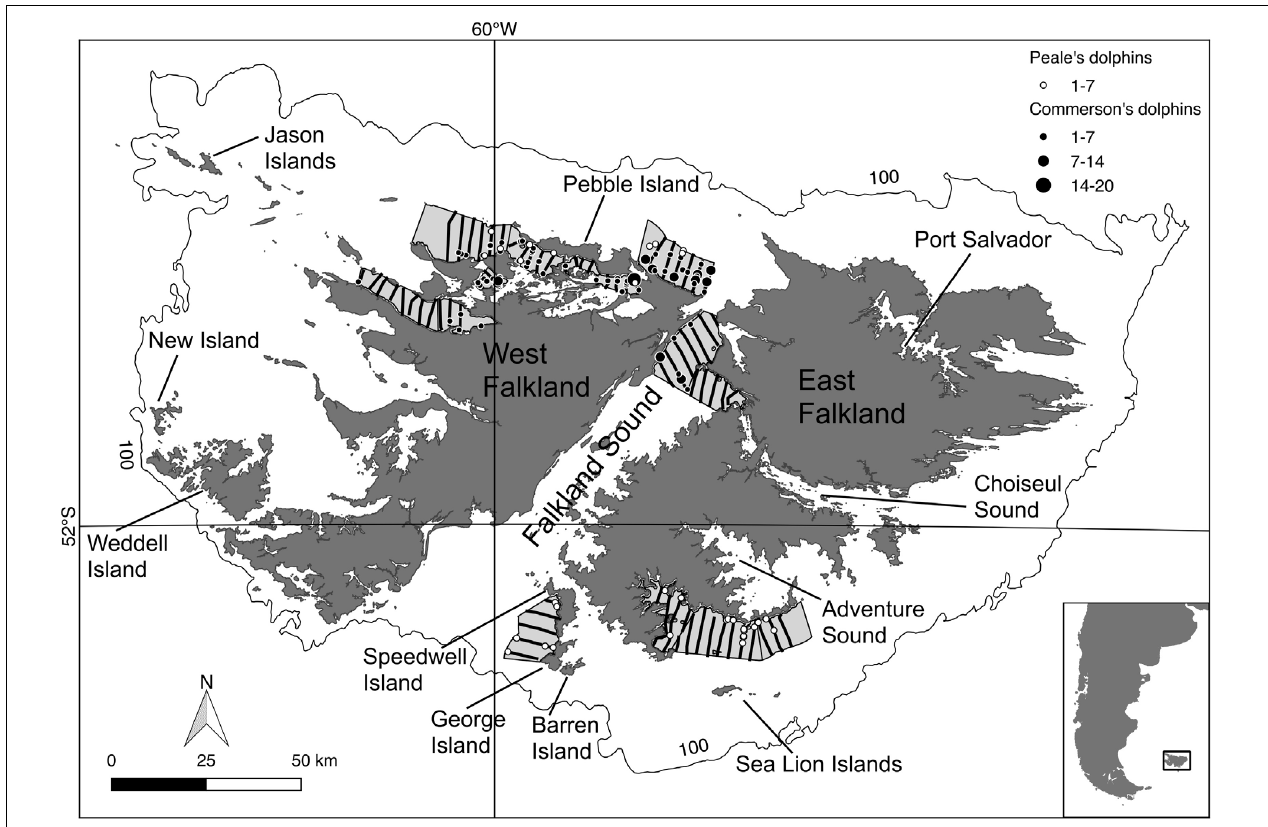
FIGURE 1 | Transect lines travelled during the 2014 ship-based survey (in black). Round symbols = sightings for Commerson’s (black) and Peale’s (white) dolphins. Symbol size is proportional to the observed group size. Light-grey polygons = surveyed area, outer line = 100 m isobath. Inset map: Falkland Islands in relation to South